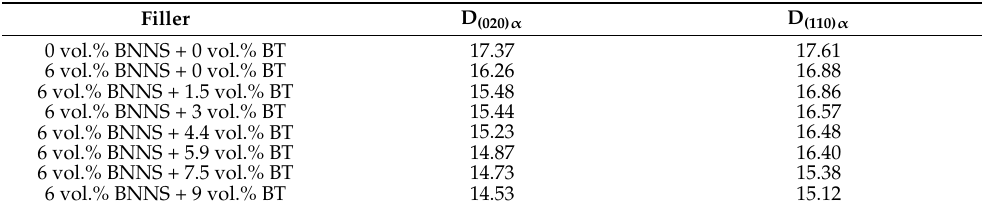
Table 1. The mean size of crystallite for (020) and (110) faces of pure P(VDF-HFP) and the nanocom- posites, from the XRD results.